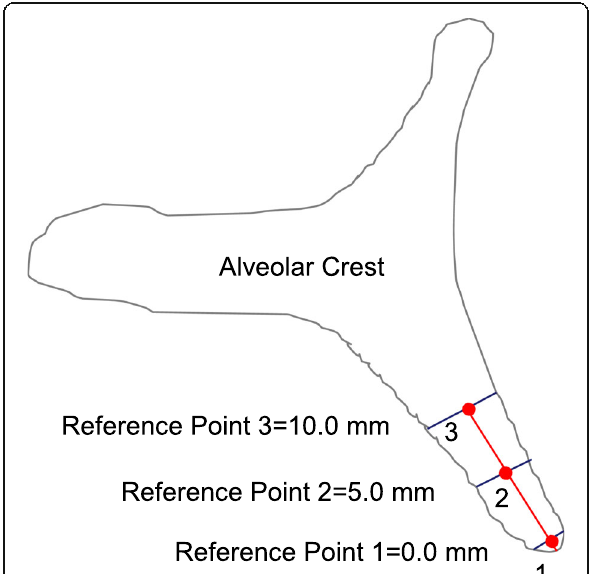
Fig. 1 CBCT measurements of the alveolar crest at implant site